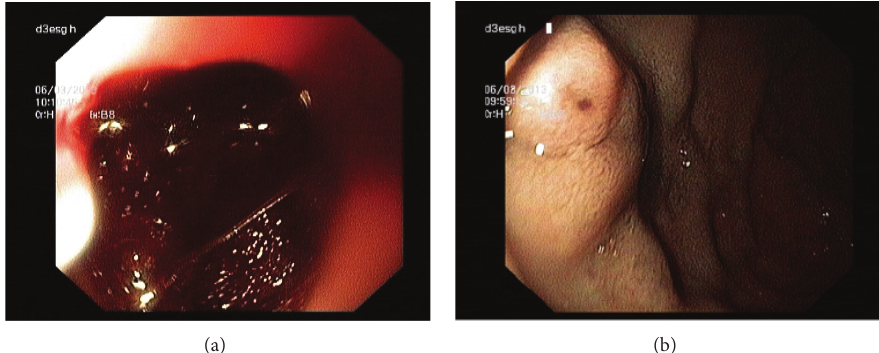
Figure 1: (a) Upper GI endoscopic image showing fresh blood in stomach. (b) Upper GI endoscopic image showing large duodenal varices.